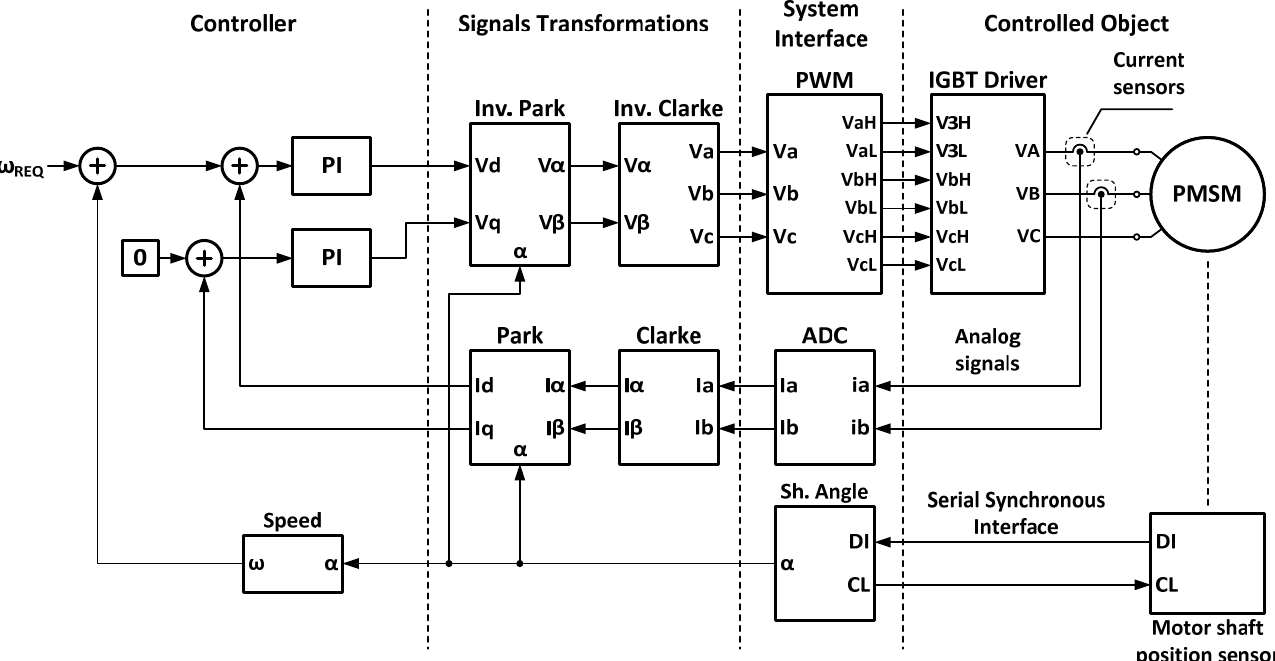
Figure 1. The general structure of the PMSM control system.